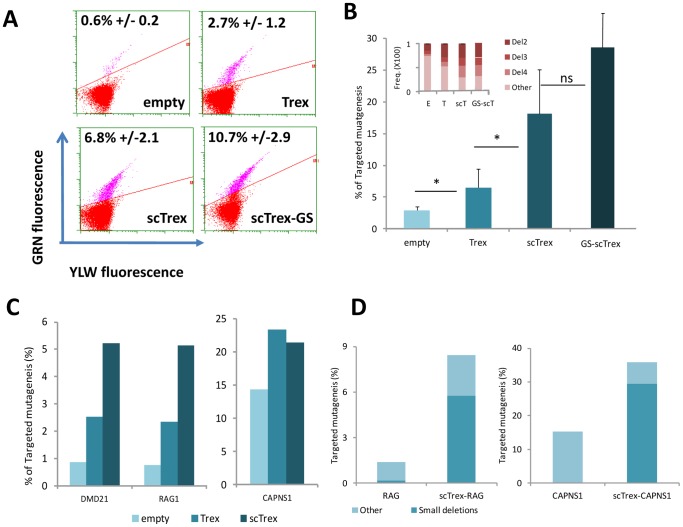
Effect of Trex2, scTrex or scTrex fused to meganuclease on meganuclease-induced mutagenesis.(A) Quantification by flow cytometry of the percentage of GFP positive cells 3 days post transfection with meganuclease alone (empty), with meganuclease and Trex2 or scTrex and meganuclease fused to scTrex; experiments performed in triplicate. (B) Determination of meganuclease-induced TM by sequence analysis of locus specific amplicons in the presence of wild-type Trex2 (Trex2), the engineered single-chain variant (scTrex) or meganuclease fused to scTrex. The inset graph shows the percentage of 2, 3, and 4 nucleotide (Del2, Del3, Del4) deletions among all TM events. E, meganuclease alone; T, meganuclease with Trex2; scT, meganuclease with scTrex. (C) Targeted mutagenesis at endogenous loci quantified by amplicon sequencing analysis. On average 10,000 amplicons were sequenced per experiment. Percentage of TM induced by meganucleases RAG1m, DMD21m (left panel) or CAPNS1m (right panel) are depicted. Empty, meganuclease alone; Trex2, meganuclease with wild-type Trex2. (D) scTrex was fused, respectively, to meganucleases targeting the hCAPNS1 and hRAG1 genes, and TM was determined by sequence analysis of locus specific amplicons.